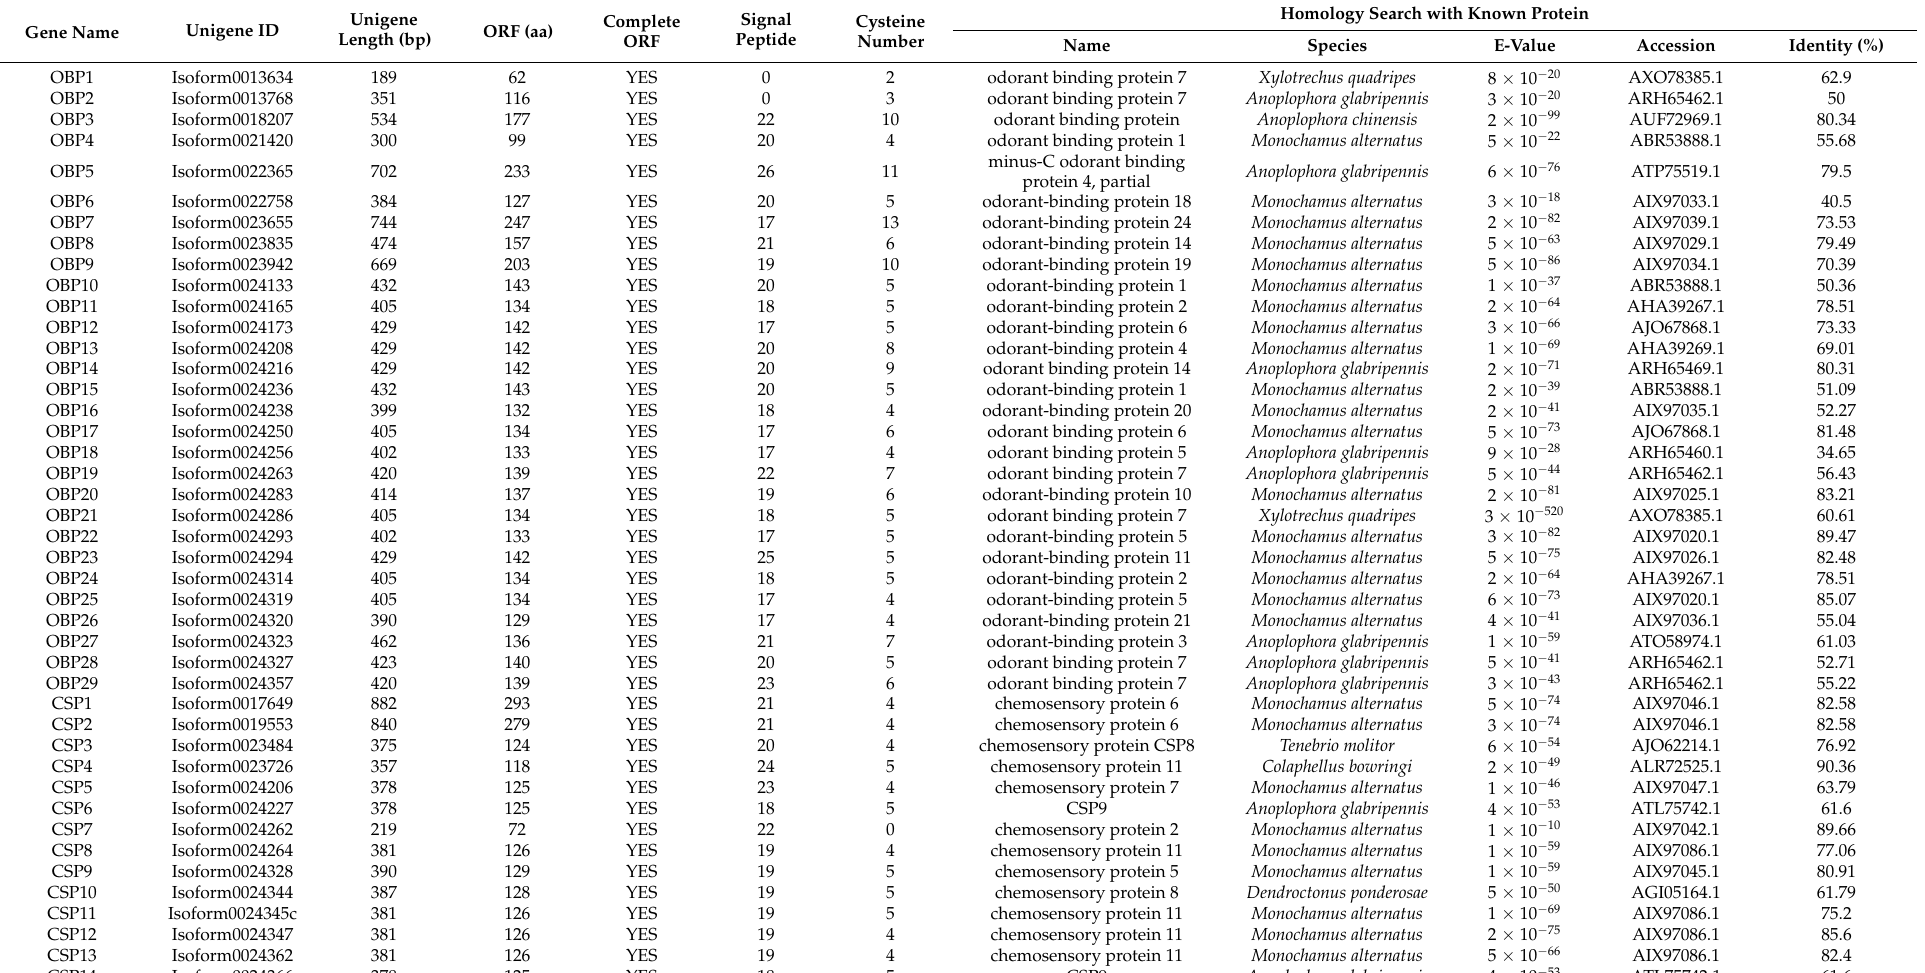
Table 2. OBPs and CSPs identified in Glenea cantor